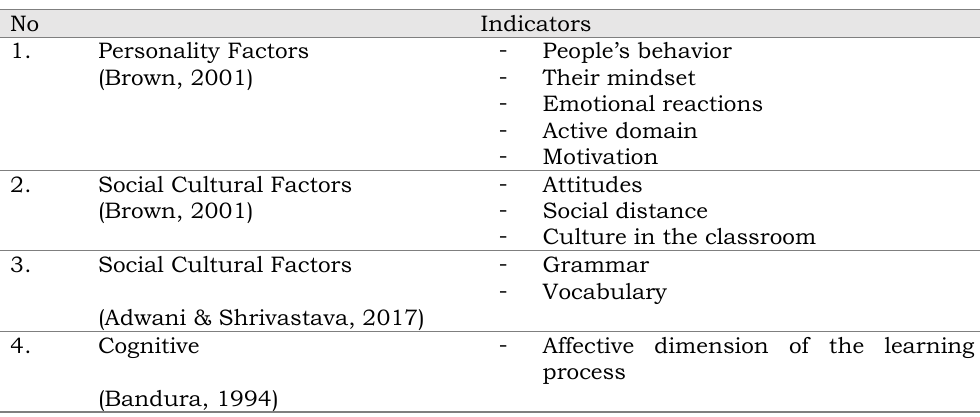
Table 1. Indicators of the